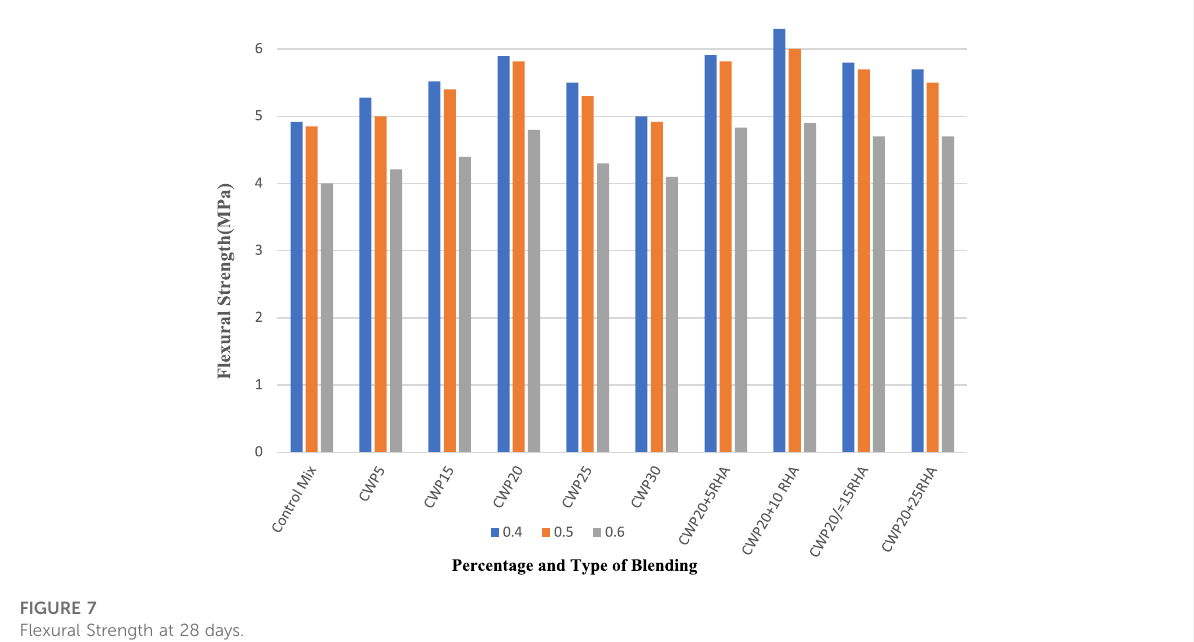
FIGURE 6 Splitting Tensile Strength at 28 days.